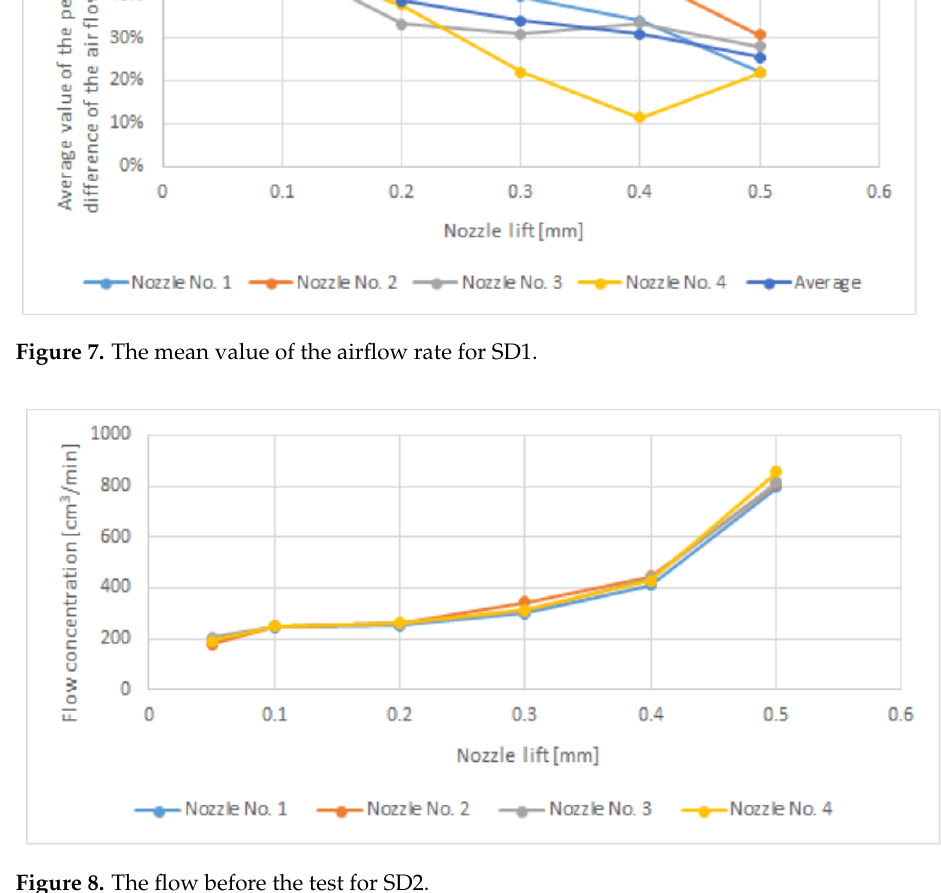
Figure 8. The flow before the test for